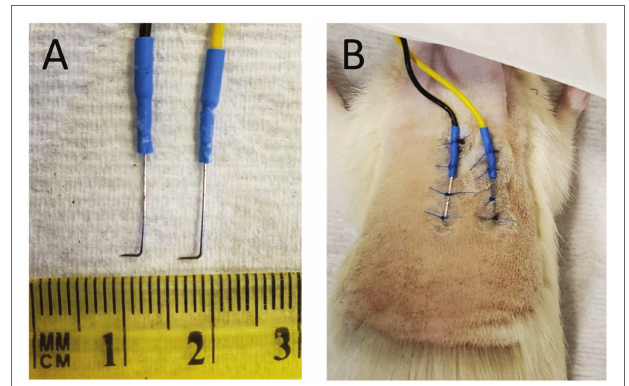
FIGURE 1 | (A) Subdermal needle electrodes after removal from animal, postmortem. The length of the tip distal to the 90 ° bend ranged from 1 to 3 mm. ( B) Subdermal needles implanted in the back of a euthanatized animal prior to